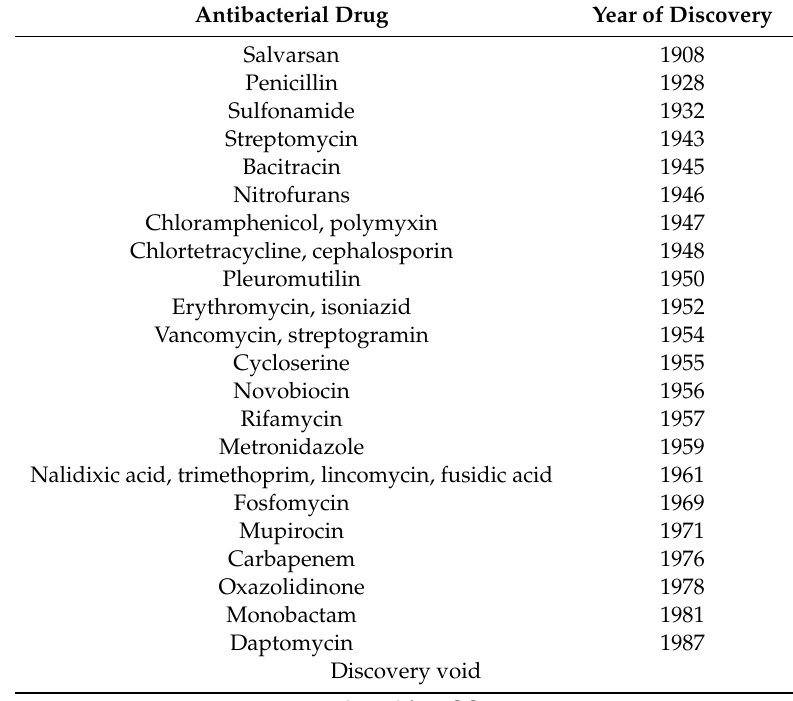
Table 3. Dates of discovery of the classes of antibacterial drugs.